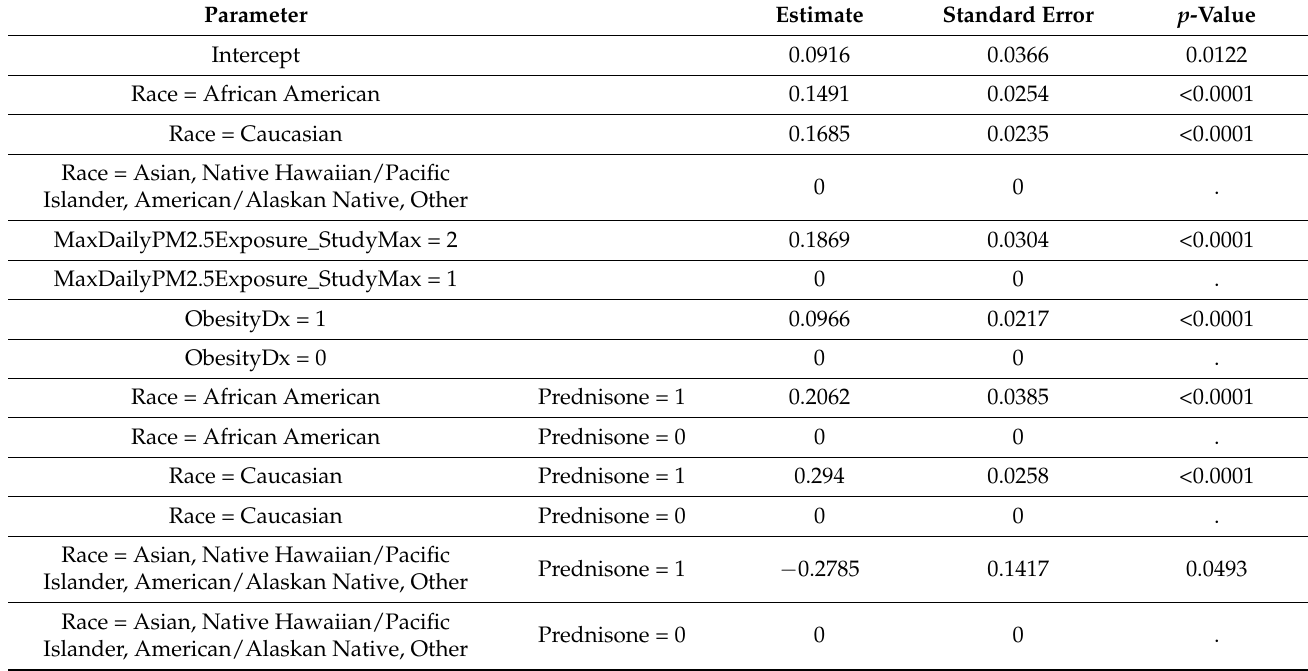
Table 3. Final GLM model output.